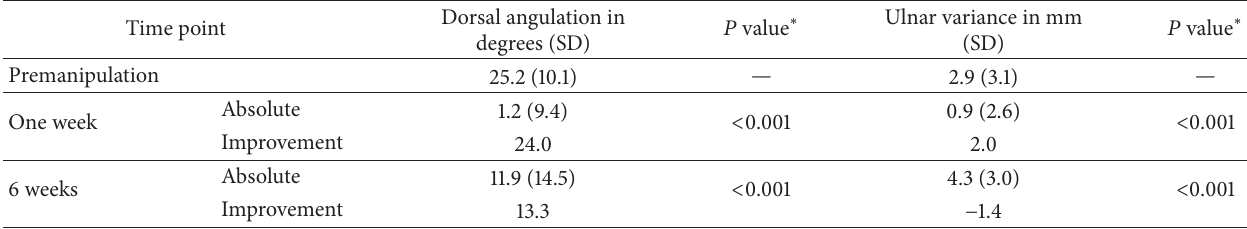
Table 2: Dorsal angulation and ulnar variance pre- and postmanipulation and the statistical significance of improvement relative premanipulation measurement.